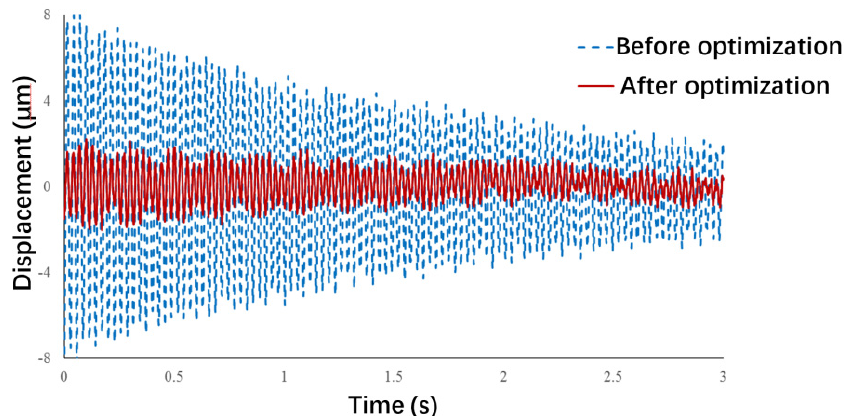
Figure 10. Test results of vibration displacement response.